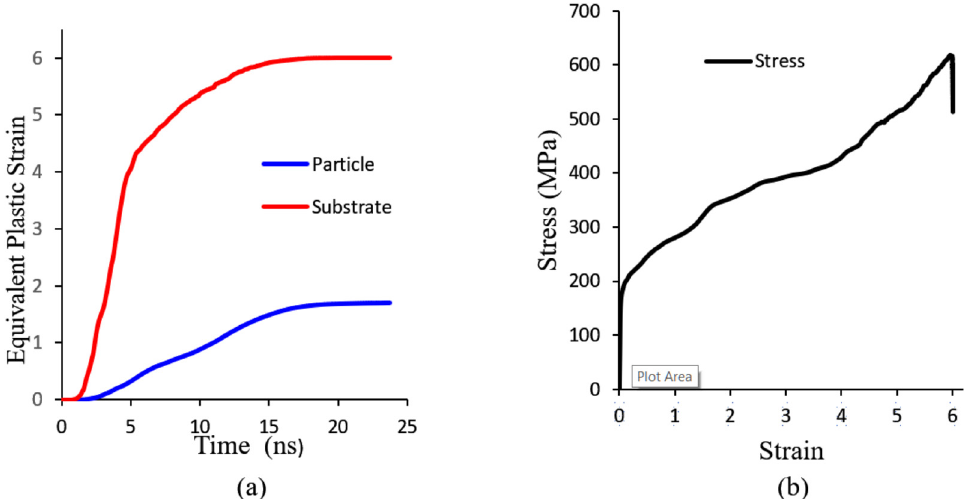
Fig. 6. The evolution of (a) PEEQ (b) stress distribution of Cu/Al impact at 500m/s impact velocity using the SPH numerical modelling.